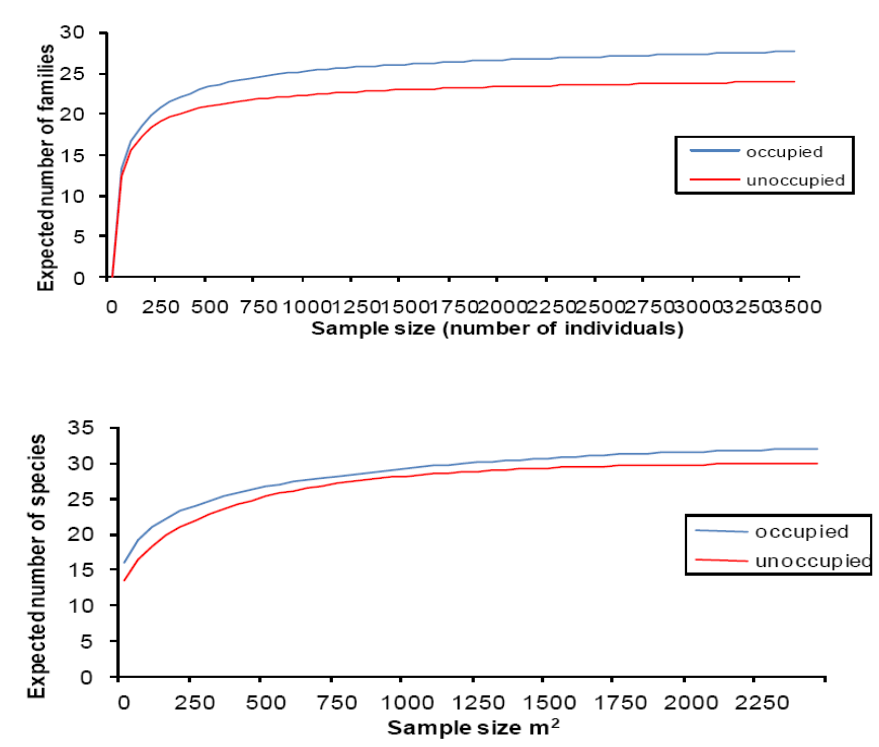
Figure 1. Rarefaction curves for macroinvertebrate families (above) and aquatic plant species (below) comparing ponds occupied or not occupied by great crested